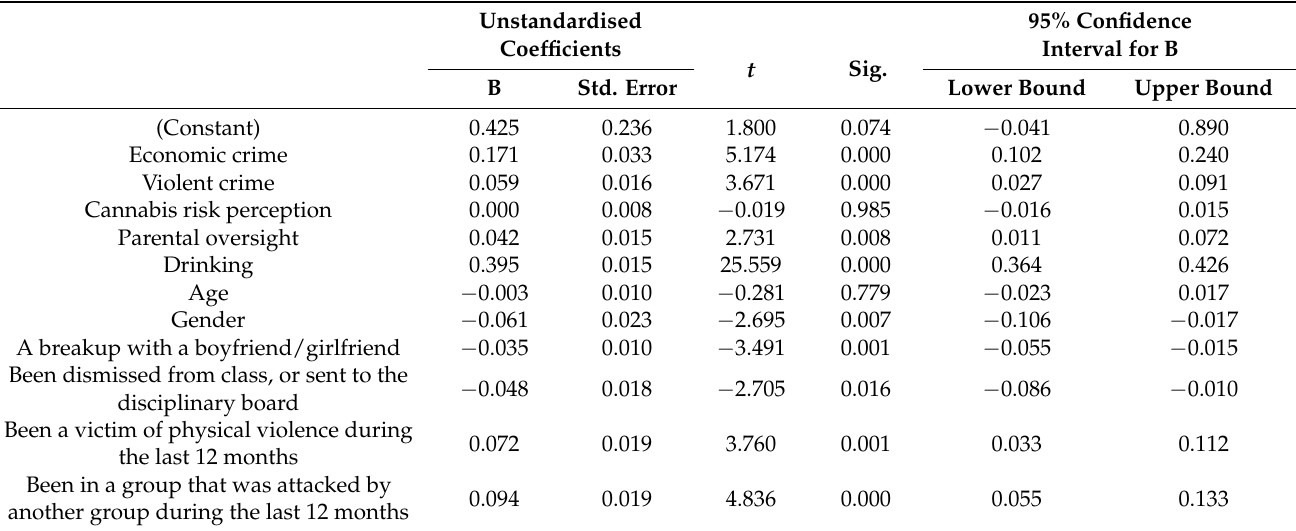
Table 5. Selected coefficient values for the computed composite variable ‘AOD use susceptibility’